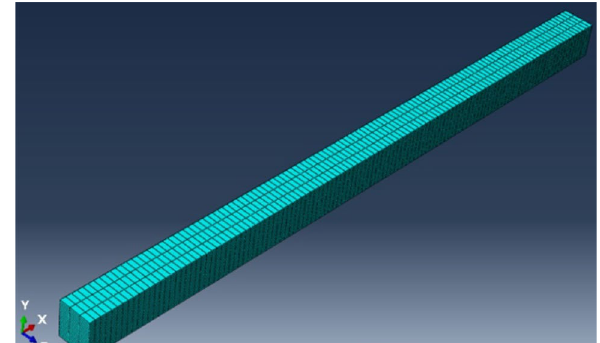
Fig. 5 a Cutter boundary condition, initial step. b Cutter boundary condition, cutting step Fig. 6 Meshing of the